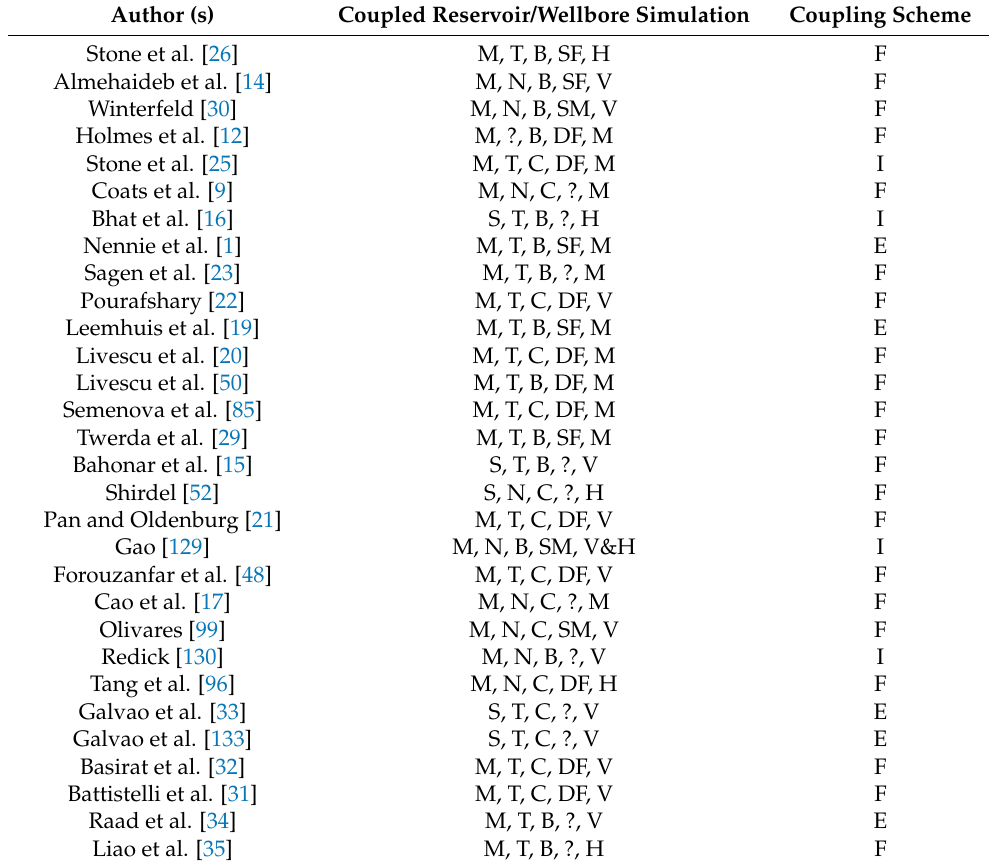
Table 3. Overview of the most representative examples of coupled reservoir/wellbore